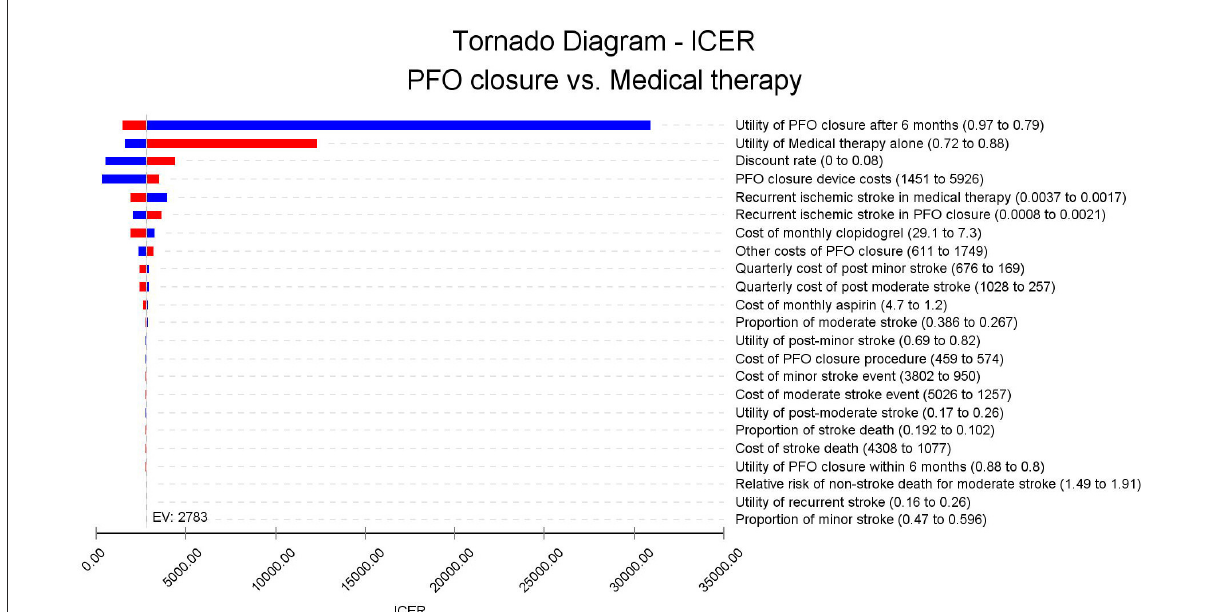
FIGURE3 Tornado diagram: ICER of PFO closure vs. medical therapy according to different model inputs. The ICER of base case analysis lies in the middle of the tornado diagram; the left and right sides of each bar in the tornado graph represent the ICER value with the lower parameter input or higher parameters input (according to the parameter description of the tornado diagram).